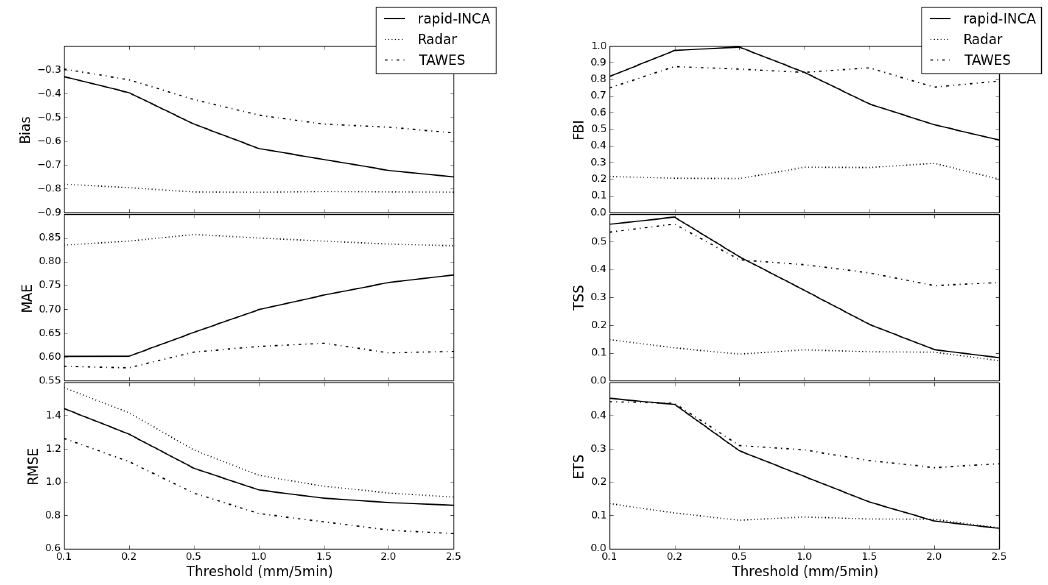
Figure 14. Mean relative error scores (bias, MAE, RMSE) and mean skill scores (FBI, TSS, ETS) computed for several